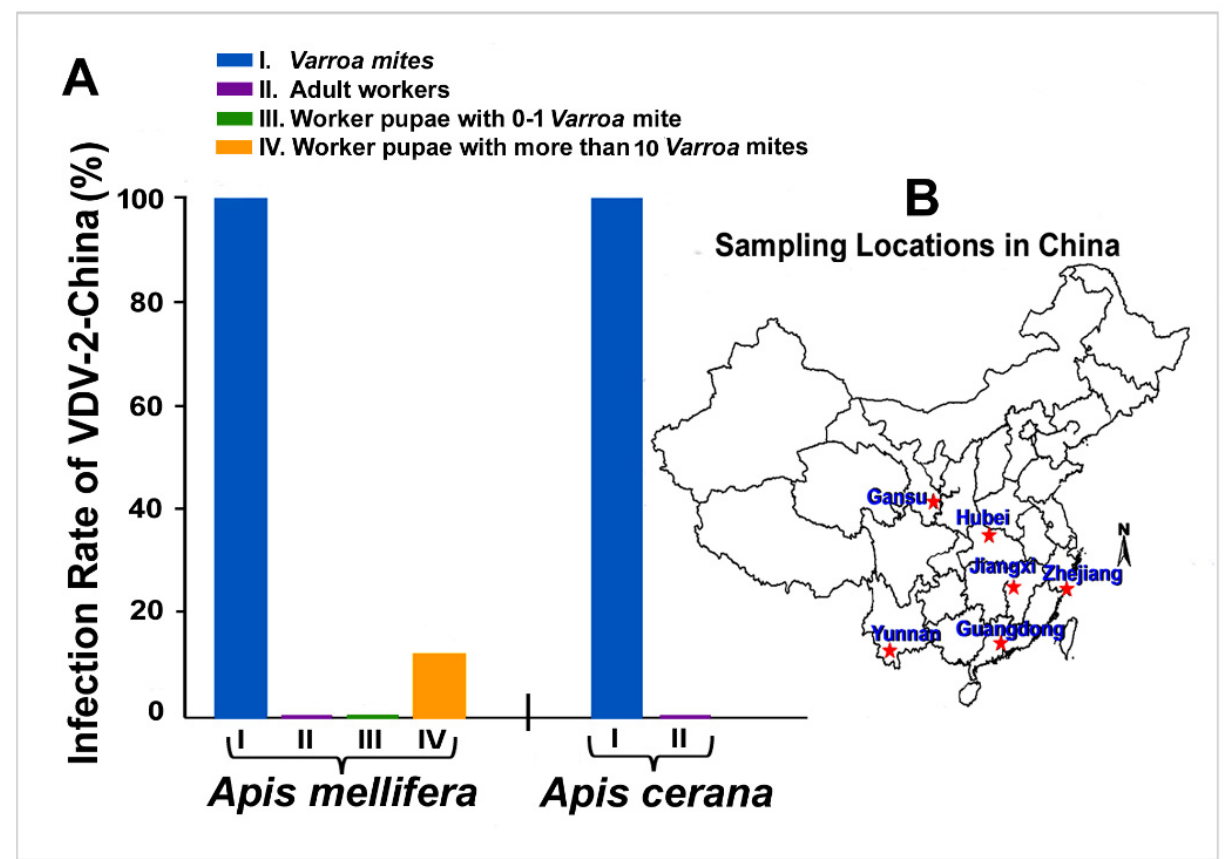
Figure 4. VDV-2-China infection in different regions of China under field conditions. ( A ) Infection rate of VDV-2-China in Varroa mites and adult workers from both A. mellifera and A. cerana colonies and worker pupae with low levels of Varroa parasitism, and worker pupae with high levels of Varroa parasitism from A. mellifera colonies. ( B ) A map of China showing the sampling location of the study. A. mellifera and A. cerana worker samples were collected in six provinces located in south central and eastern regions of China, including Gansu, Hubei, Jiangxi, Zhejiang, Yunnan, and Guangdong.